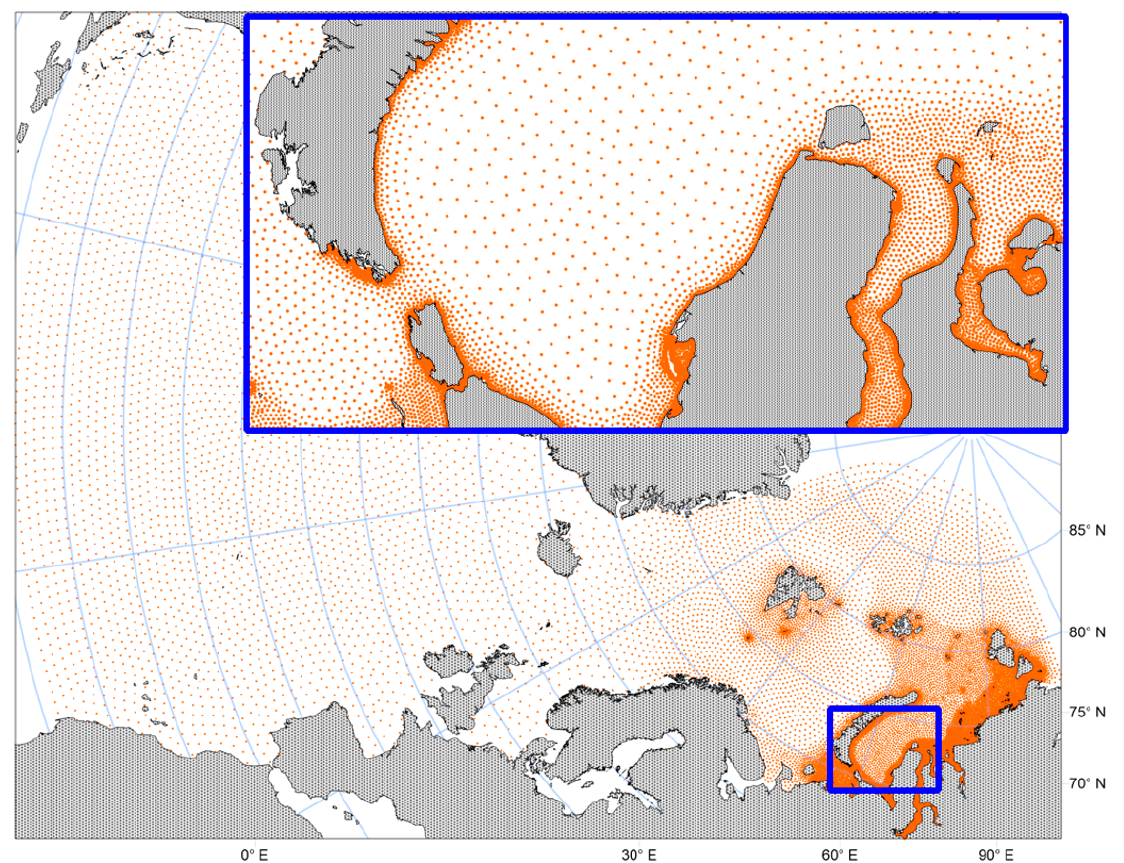
Figure 1. Unstructured computational grid of the WWIII model for the North Atlantic and the Kara